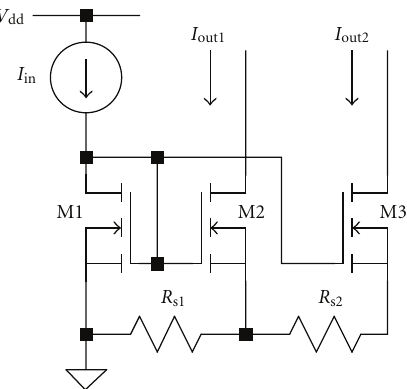
Figure 6: NMOS current mirror with two outputs and supply